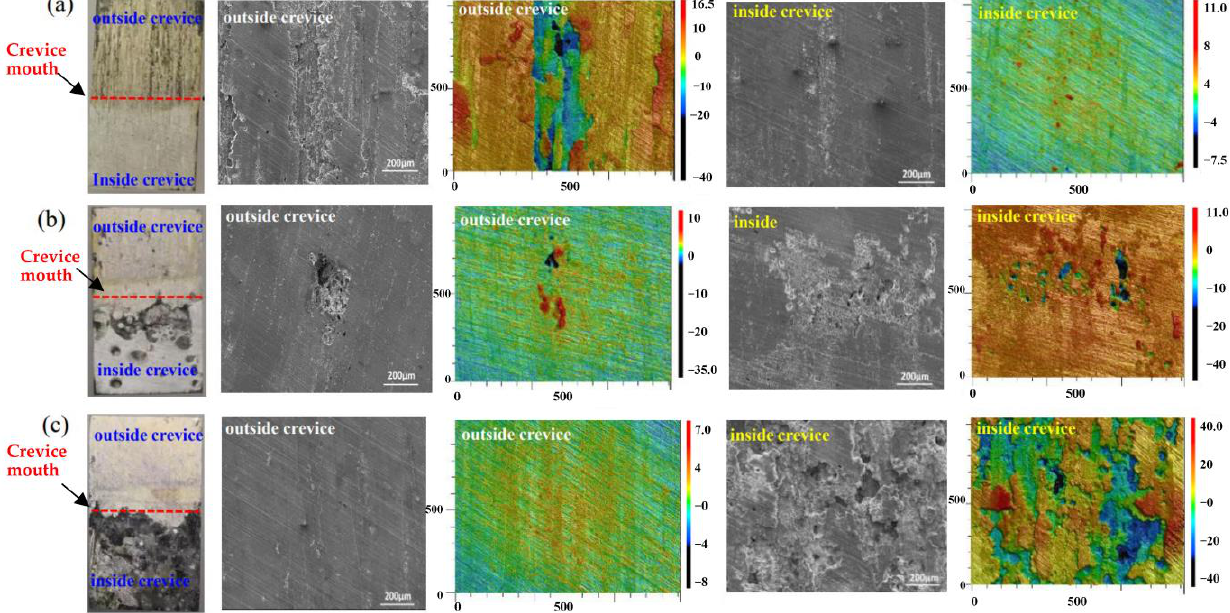
Figure 7. The evolution of the pH inside the crevice in solutions with different concentrations of NaNO 3 .